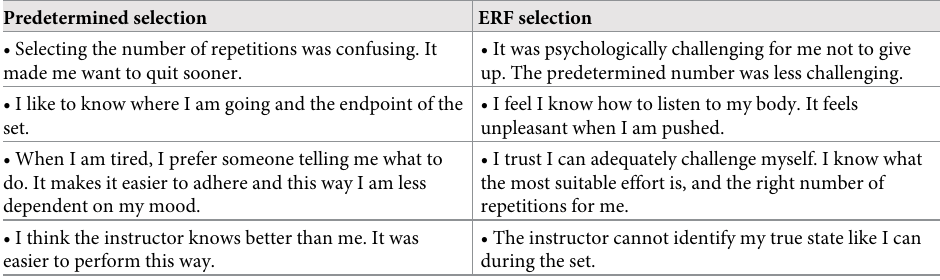
Table 4. Examples of participants’ responses to the question: "Which training approach did you prefer?". Predetermined